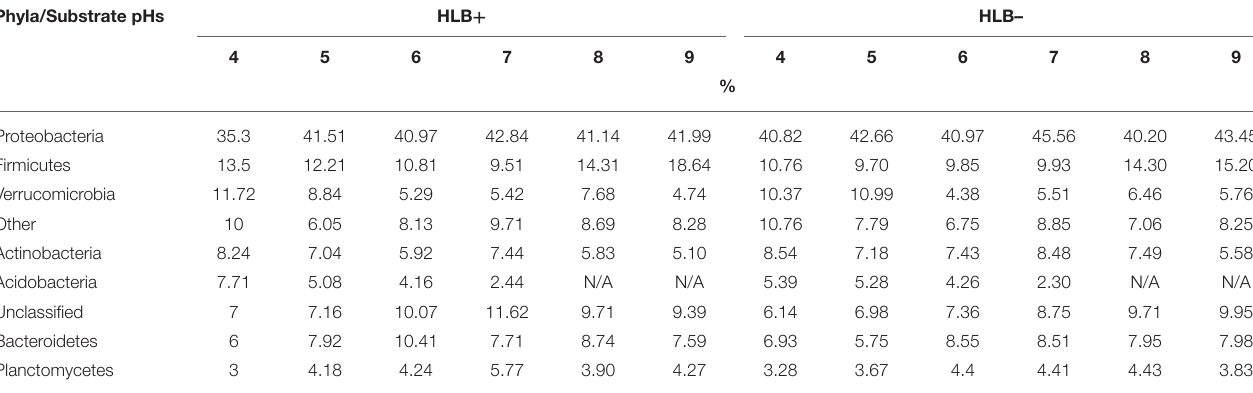
TABLE 5 | Illumina top eight phyla classifications percentages of “Ray Ruby” grapefruit ( C. paradisi ) on sour orange ( C. aurantium ) rootstock exposed to different HLB disease statuses [HLB-free or healthy (negative, HLB–) and HLB-affected (positive, HLB + )] under an increasing range of substrate pHs (4–9). Phyla/Substrate